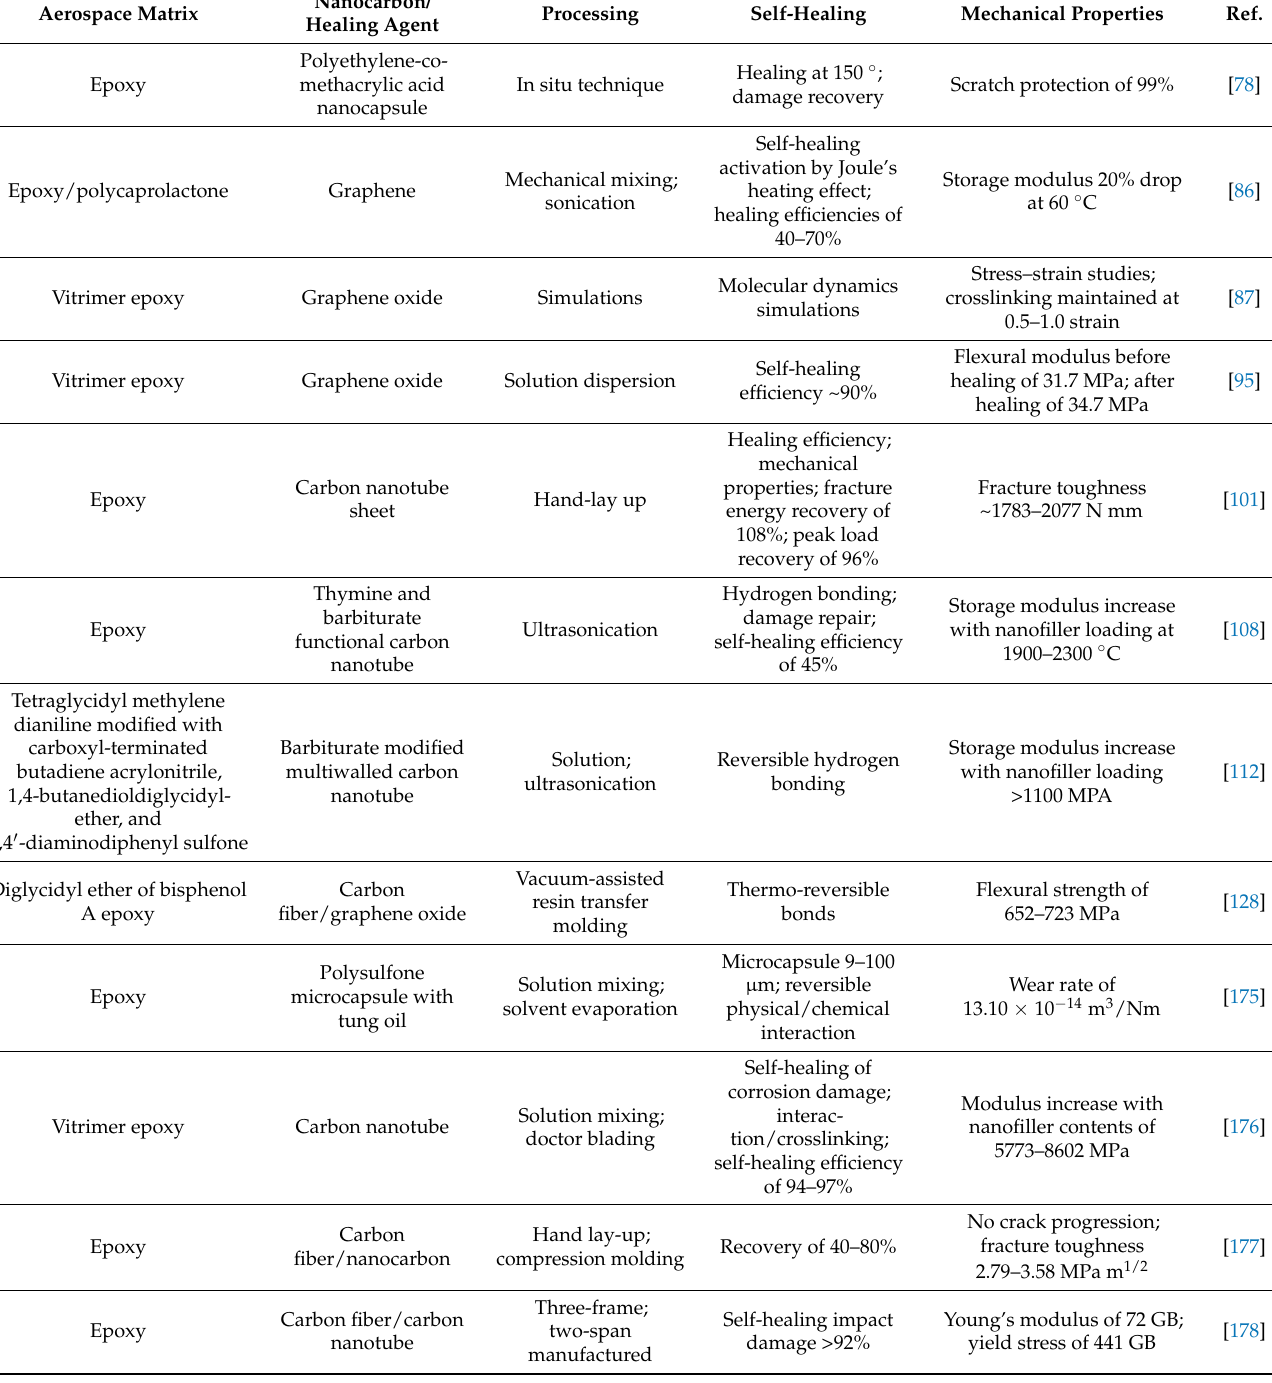
Table 3. Design, processing, self-healing and mechanical properties of aerospace